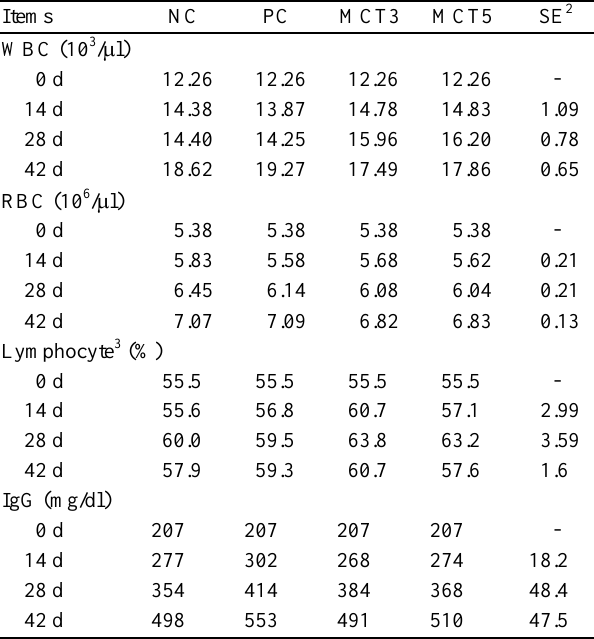
Table 3. Effect of medium-chain-triglyceride on apparent total tract nutrient digestibility (ATTD) of weanling pigs (Exp. 1) 1 Items